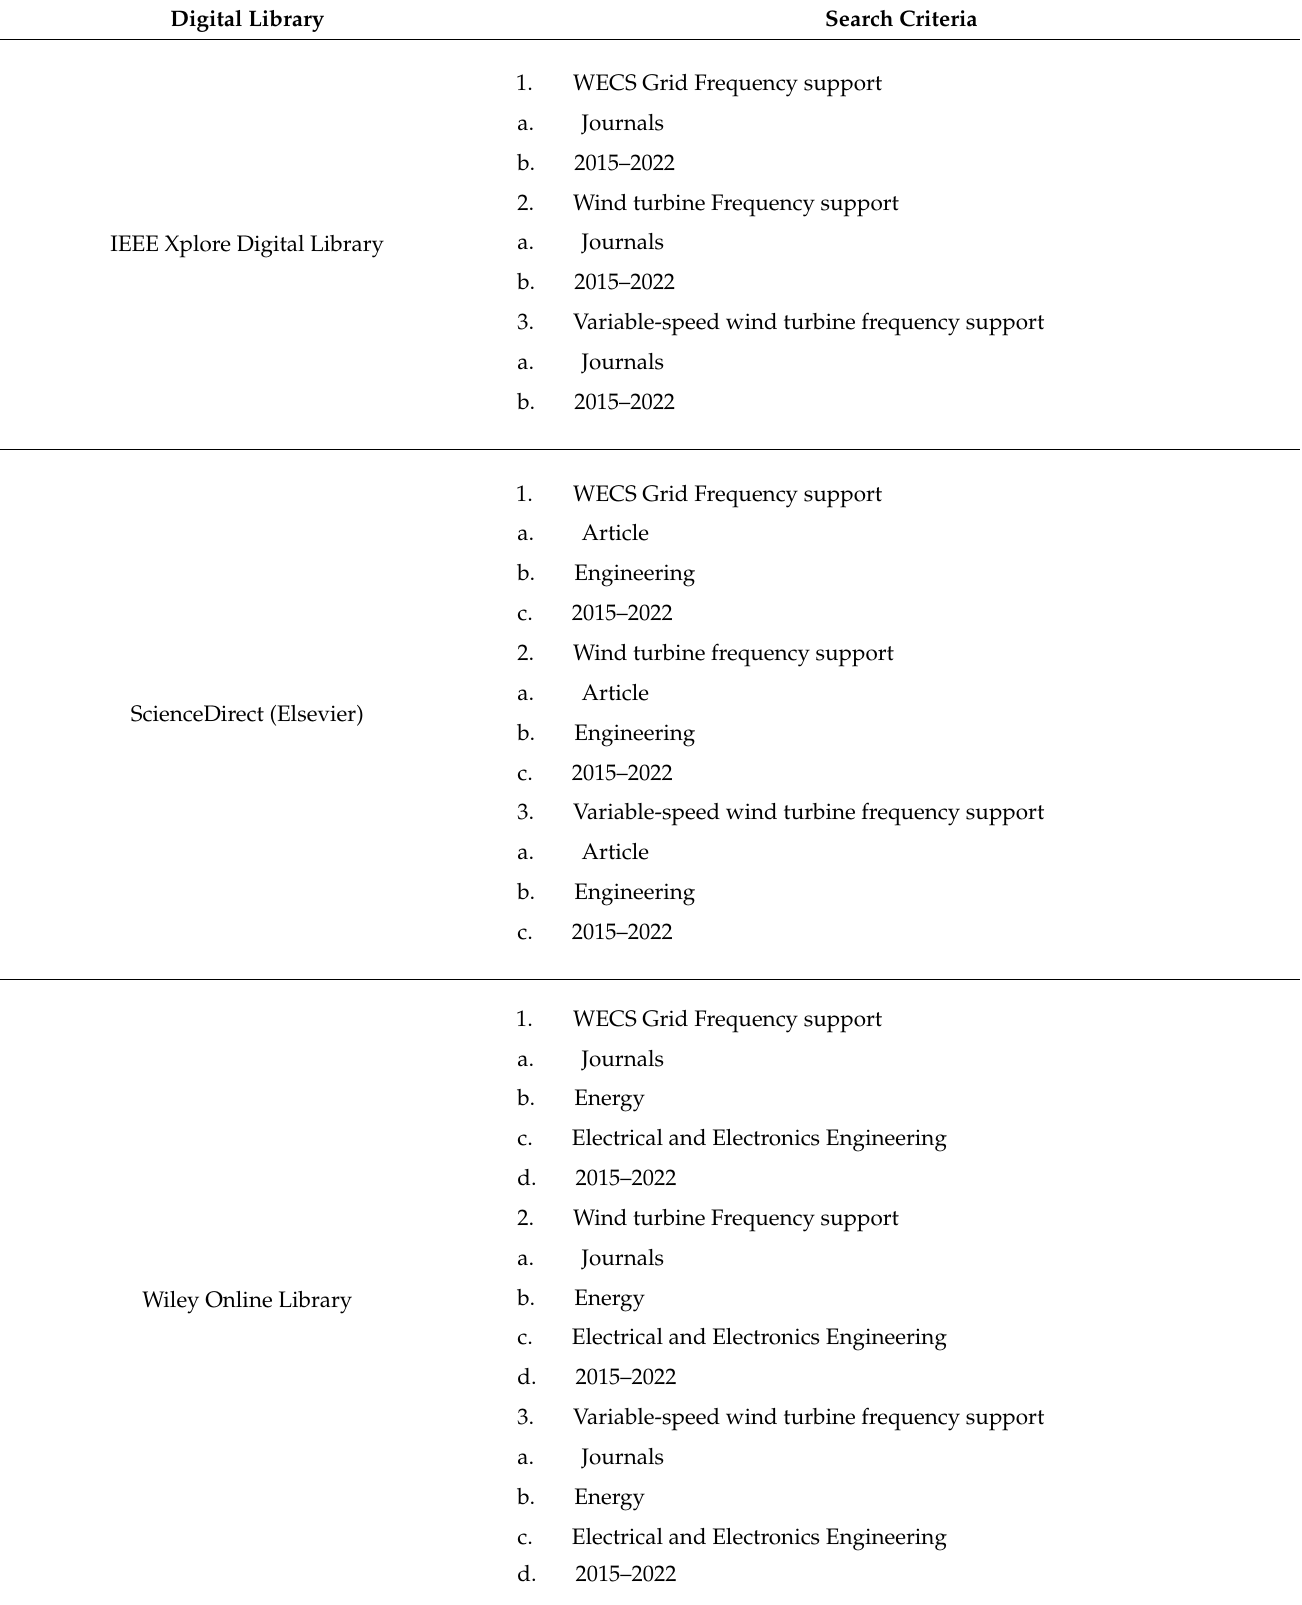
Table 1. Search Criteria